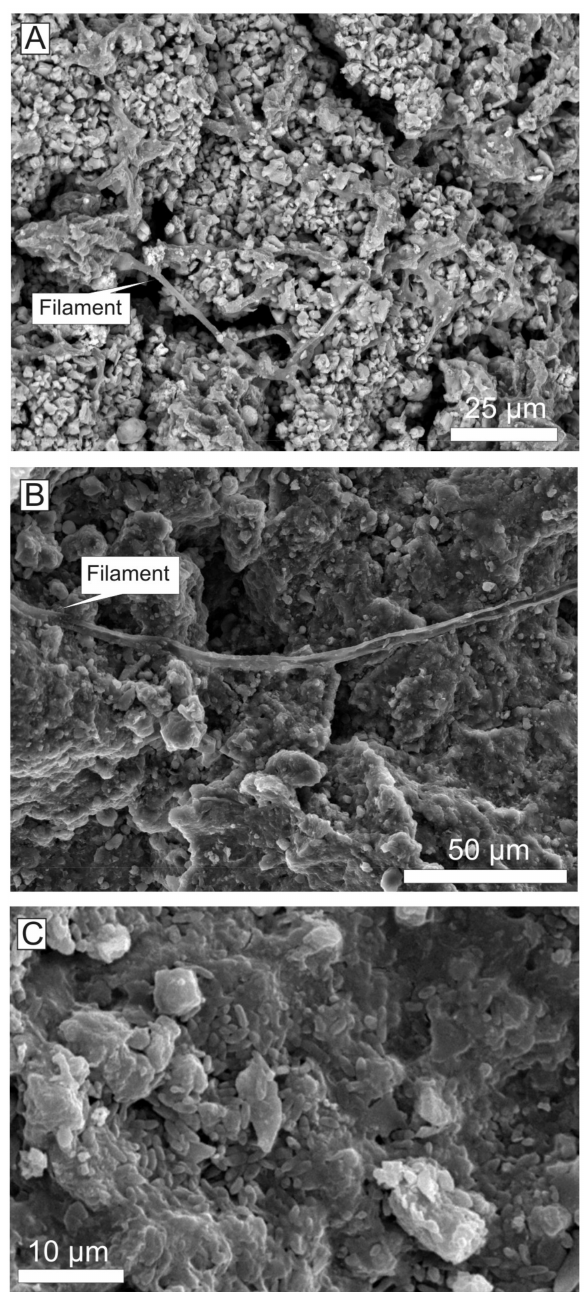
Figure 12. SEM images of fossil microbial structures registered inside iron macro-oncoids (Eastern External Subbetic). ( A ) Web of branched filaments. ( B ) Detail of a filament. ( C ) Aggregates of bacillus-shaped